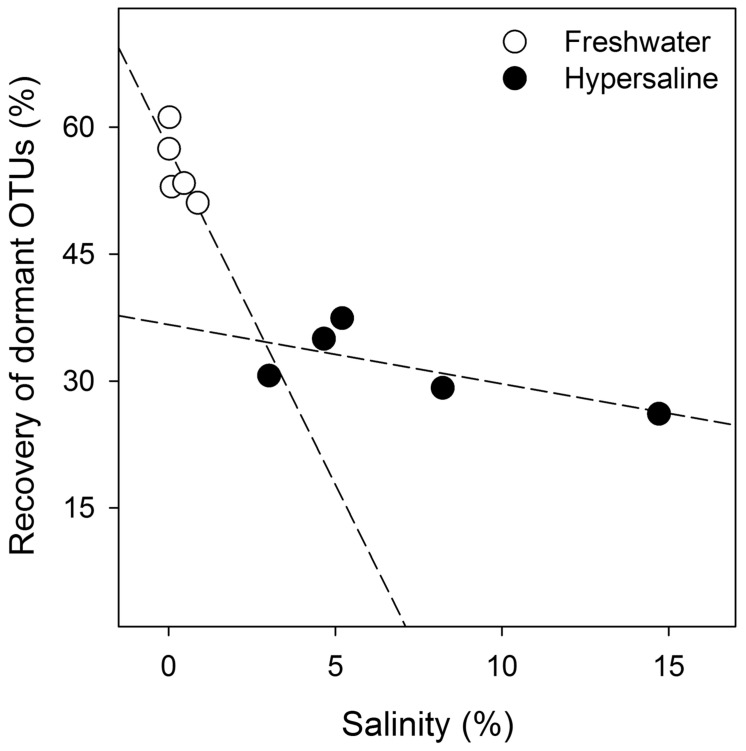
Bacterial dormancy decreases as lake salinity increases. The indicator regression analysis (R2 = 0.96, F8,1 = 50.0, P < 0.001, n = 10) was based on the relative recovery of dormant OTUs at the cutoff of 0.5 from the equation 1 - (rRNA recovery/rDNA recovery). Dormancy was calculated for each OTU from rDNA and rRNA community libraries.